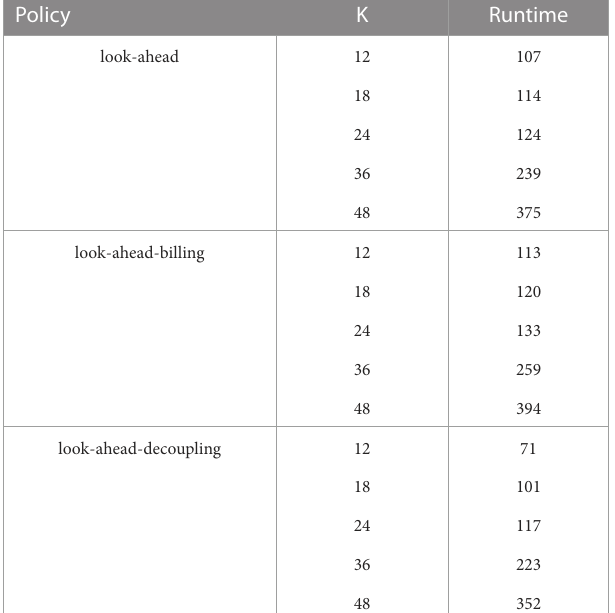
TABLE7 Runtime(inseconds)ofthethreepoliciestestedinthesecondREC.